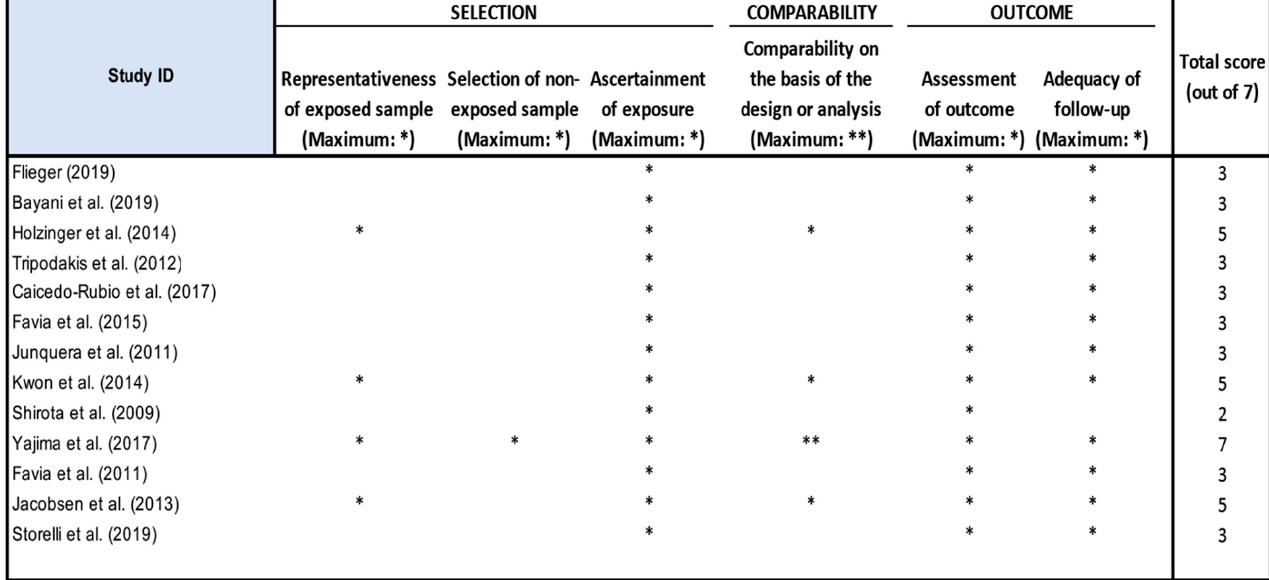
Figure 2 . Qualitative assessment of the studies by the Modified Newcastle-Ottawa Quality Assessment scale for Cohort and Case-Control Studies (m-NOS). (Flieger (2019) [15]; Bayani et al. (2019) [21]; Holzinger et al. (2014) [14]; Tripodakis et al. (2012) [16]; Caicedo-Rubio et al. (2017) [23]; Favia et al. (2015) [22]; Junquera et al. (2011) [24]; Kwon et al. (2014) [17]; Shirota et al. (2009) [25]; Yajima et al. (2017) [18]; Favia et al. (2011) [26]; Jacobsen et al. (2013) [19]; Storelli et al. (2019) [20]). * 1 point for the score; ** 2 points for the score.